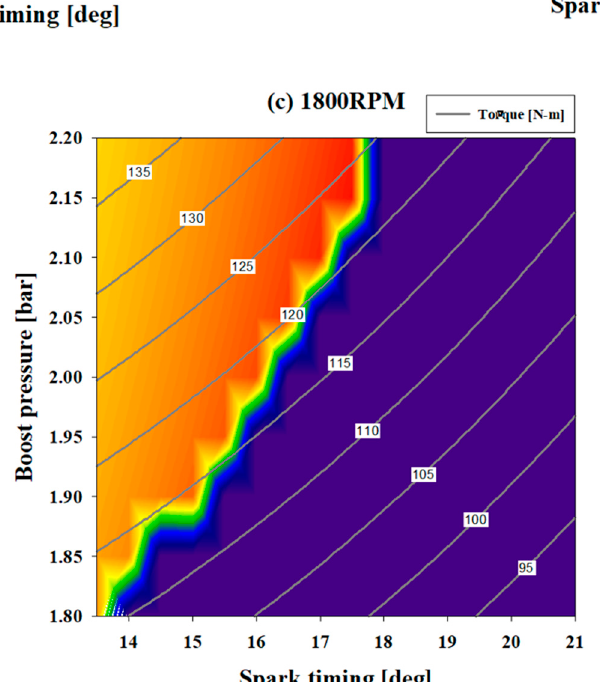
Figure 8. ( a ) Predicting knocking phenomenon according to changes in spark timing and boost pressure.at 1800 RPM. ( b ) Predicting NOx amounts according to changes in spark timing and boost pressure at 1800 RPM. ( c ) Predicting torque tendency according to changes in spark timing and boost pressure at 1800